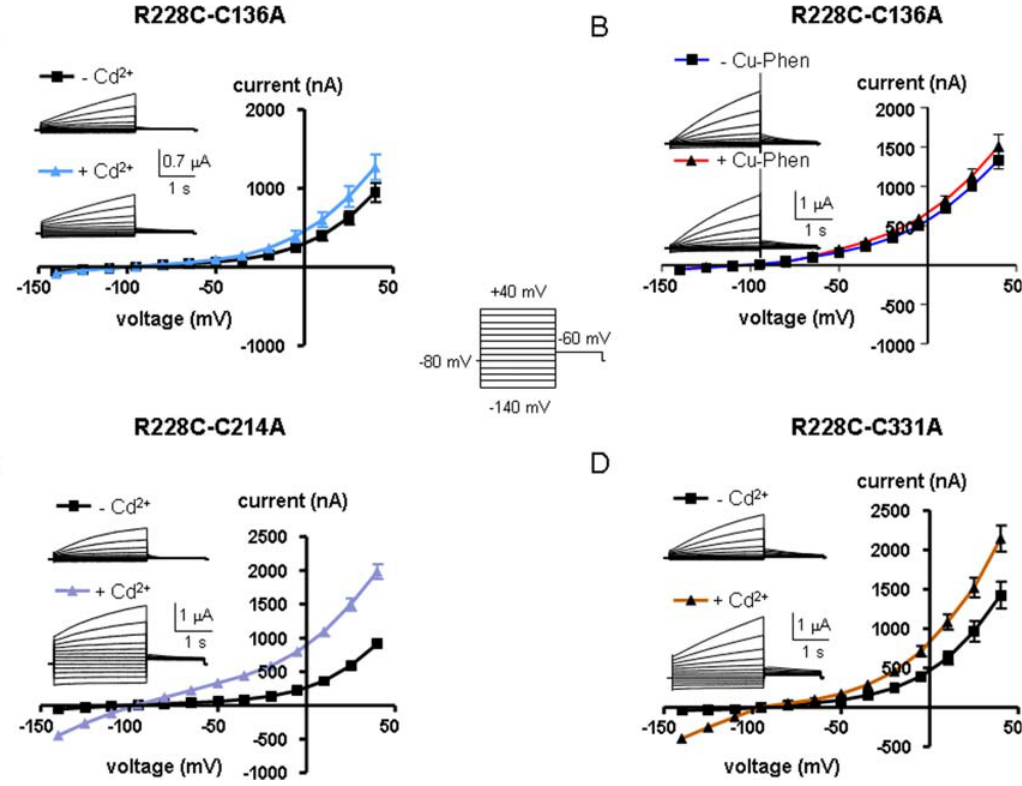
Figure 7. Effects of external Cd 2 + (A) or Cu-Phen (B) on the double mutant R228C-C136A and of Cd 2 + on R228C-C214A (C) and R228C-C331A (D). Oocytes were bathed in ND96 in the absence and presence of 100 m M CdCl 2 or 100 m M Cu-Phen. Shown are representative traces and current-voltage relations were determined as indicated.